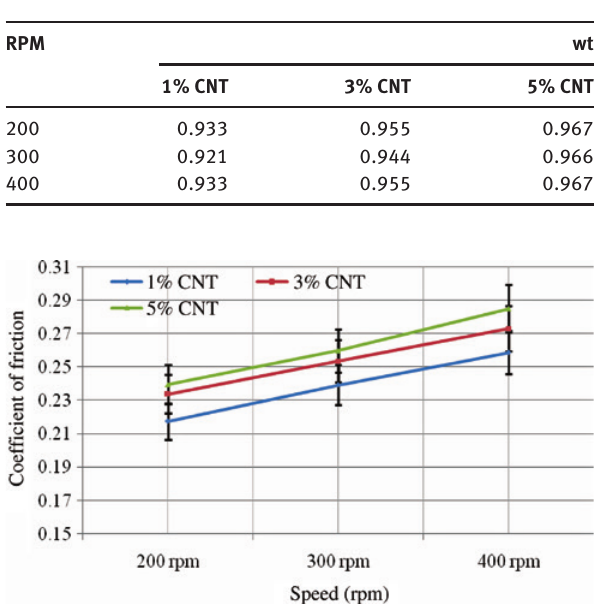
Figure 10: Difference in COF with respect to sliding velocity for different % of CNT.